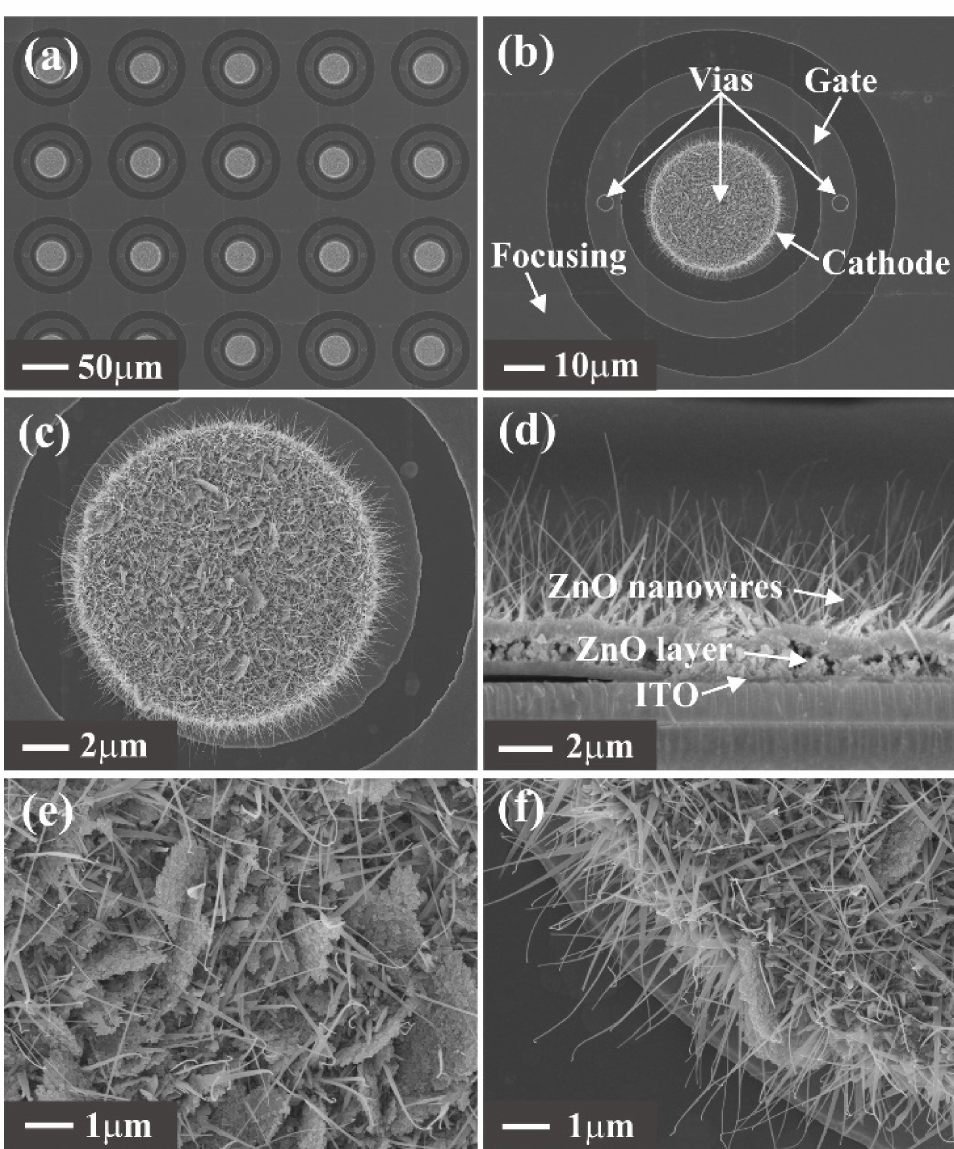
Figure 6. SEM images of the fabricated ZnO nanowire FEAs. ( a ) ZnO nanowire FEAs; ( b ) single pixel of ZnO nanowire FEAs; ( c ) the cathode pattern; ( d ) cross-sectional view of the ZnO nanowires; ( e ) ZnO nanowires at the inner part of the cathode pattern; ( f ) ZnO nanowires at the edge of the cathode